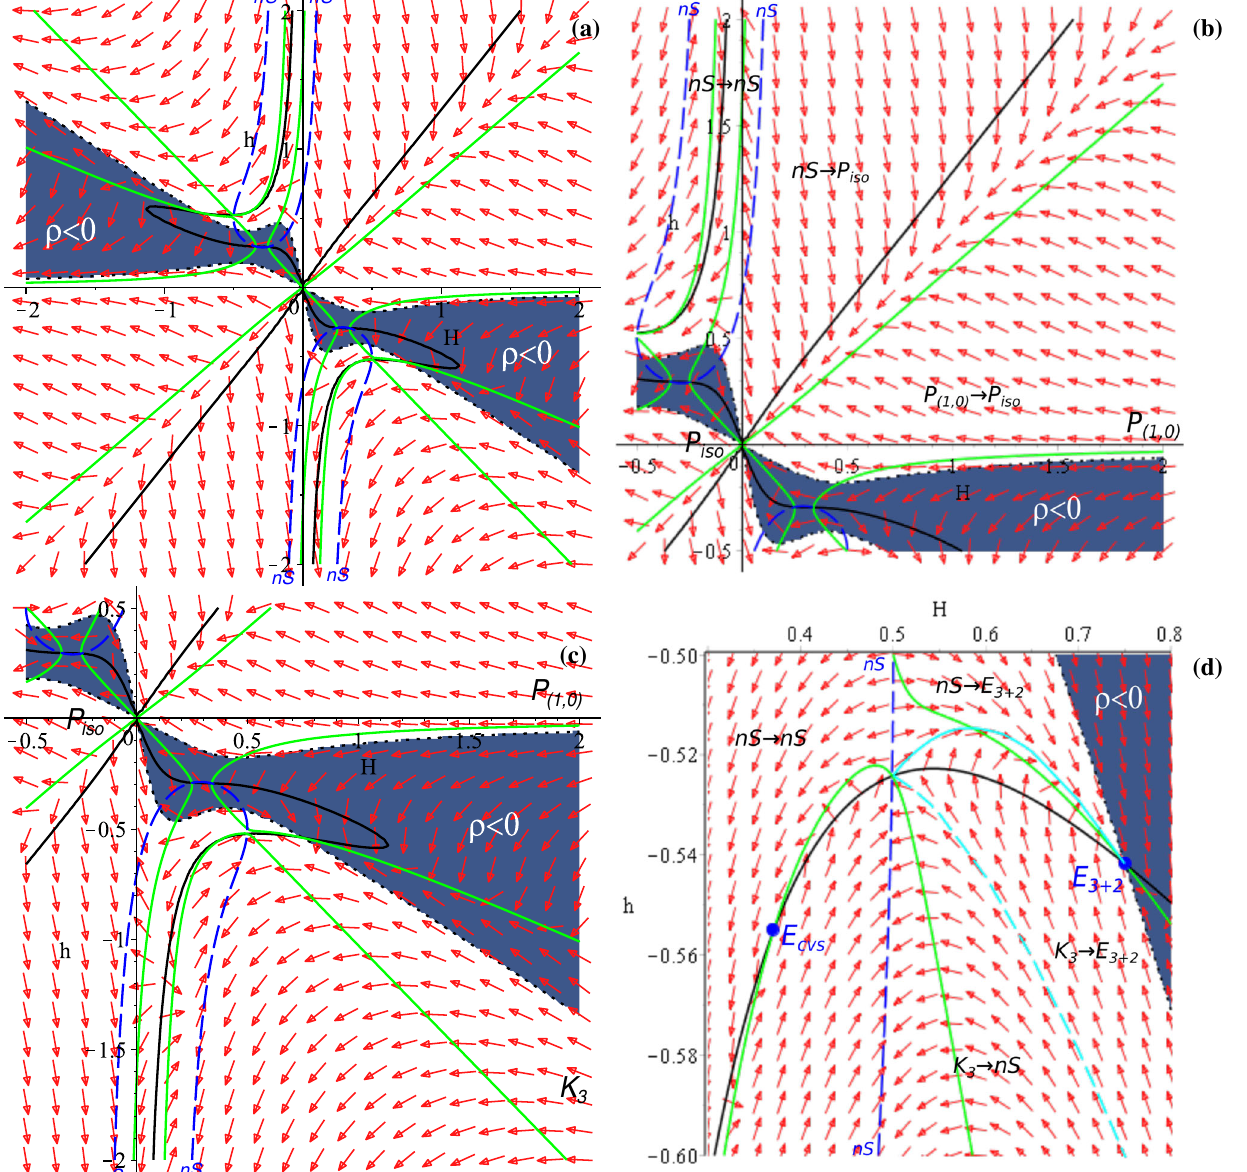
Fig. 4 Phase portraits for D = 2 α > 0, ω < 0 case: general view on a , focus on h > 0 regimes on b , focus on h < 0 regimes on c and focus on the regimes in the vicinity of E 3 + 2 solution on d . Light blue line separate initial conditions leading to different regimes. Dark